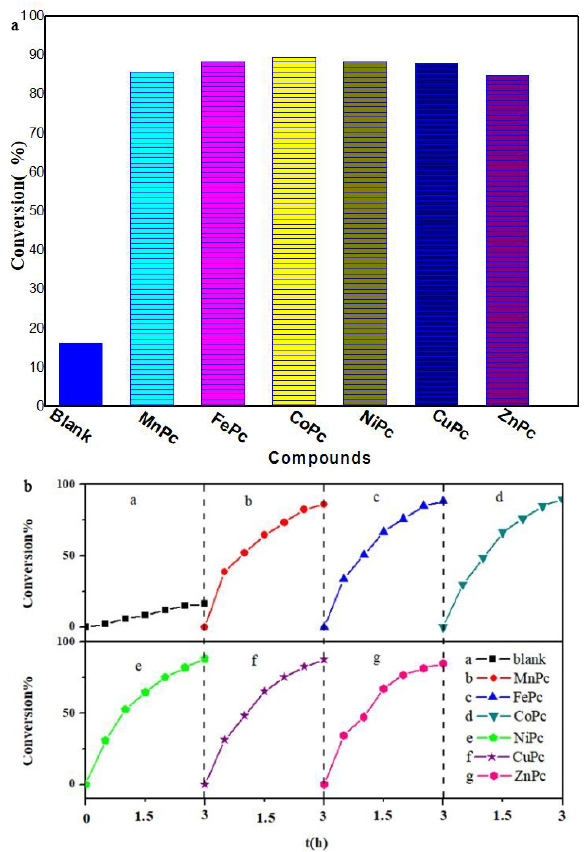
Figure 5. The influence of center metal ion of phthalocyanine. ( a ) desulfurization activities of phthalocyanine; ( b ) desulfurization activities at different time.